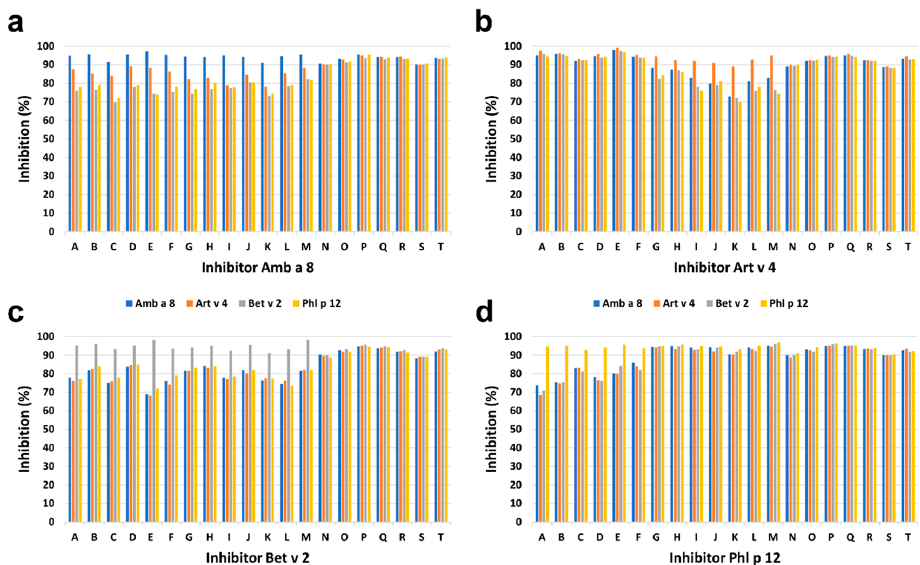
Figure 7. Results of ELISA inhibition assays, in which Amb a 8.0101 ( a ), Art v 4.0101 ( b ), Bet v 2.0101 ( c ), or Phl p 12.0101 ( d ) were used in increasing concentrations. Maximum inhibition of IgE binding by different profilins in individual patients is shown. Letters represent individual patients. Patients A–F: dominant IgE binding to Art v 4.0101; G–M: dominant IgE binding to Phl p 12.0101; N–T: no dominant IgE binding.